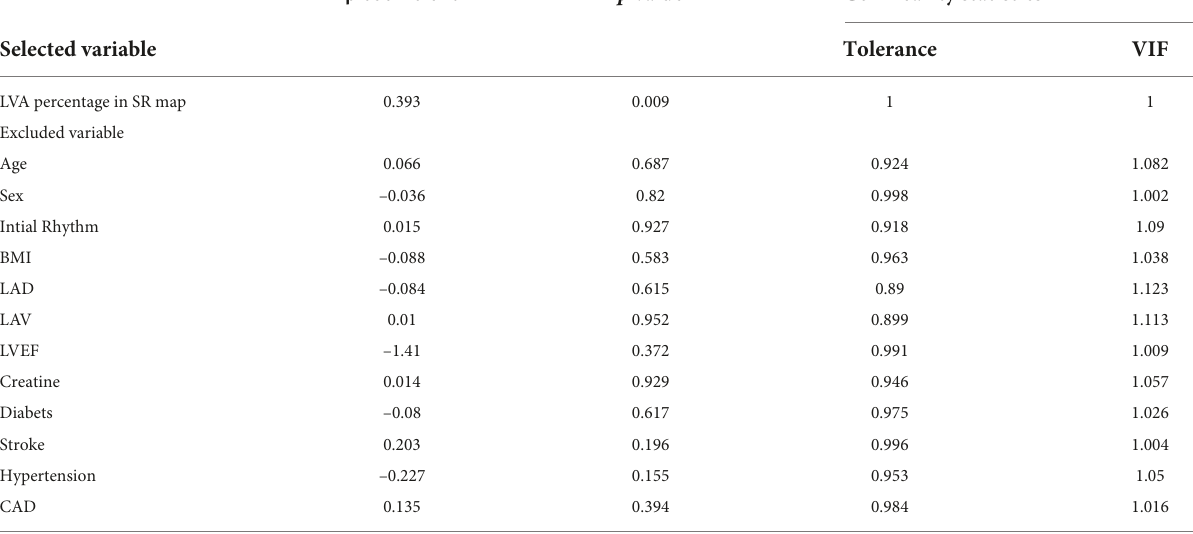
TABLE 4 Stepwise linear regression for a predictor of concordance of fractionated